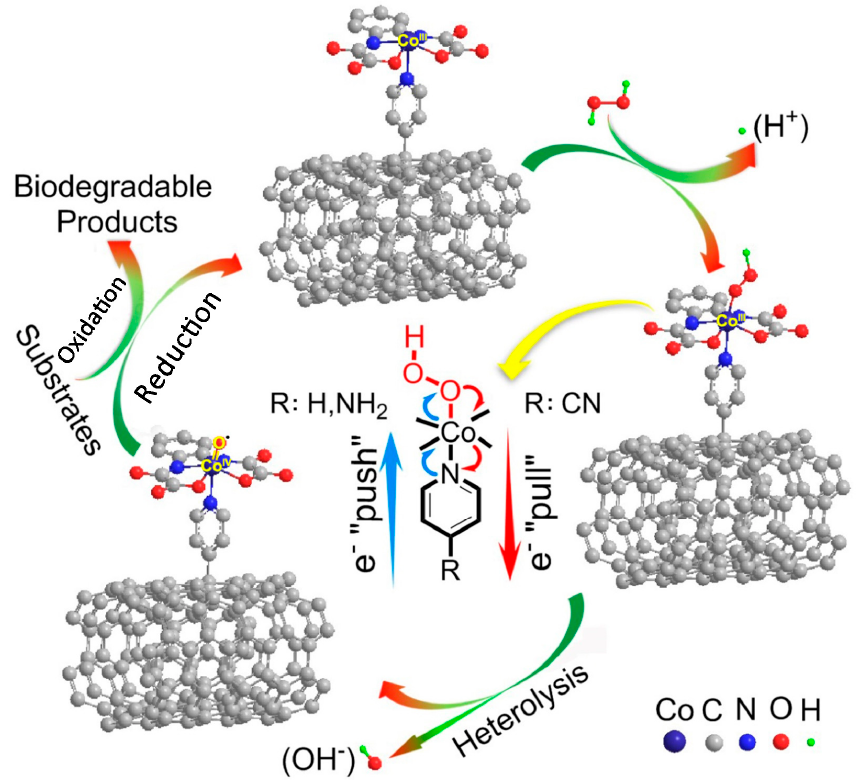
Figure 6. Proposed reaction mechanism of substrates over [Co III (opba)] − -Py-MWCNTs.